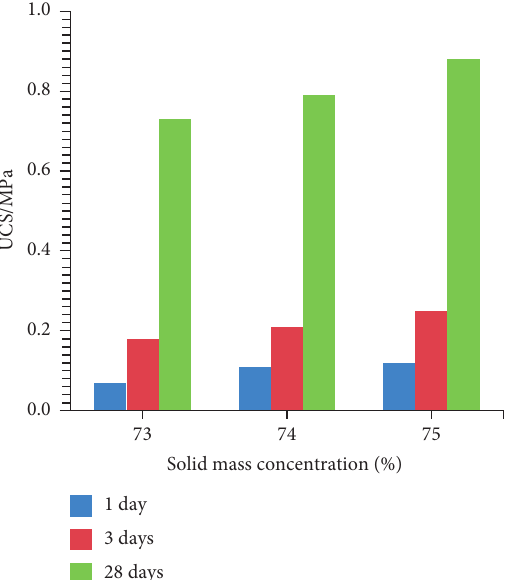
Figure 9: The results of UCS of CPB with cement/sand ratio of 1 :8.